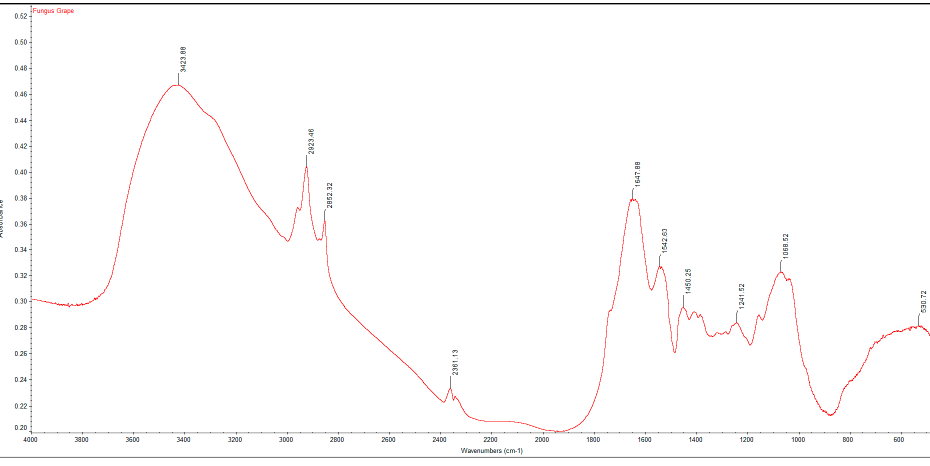
Figure 3. FTIR spectra of fungal chitosan extracted after fermentation on red grape pomace.